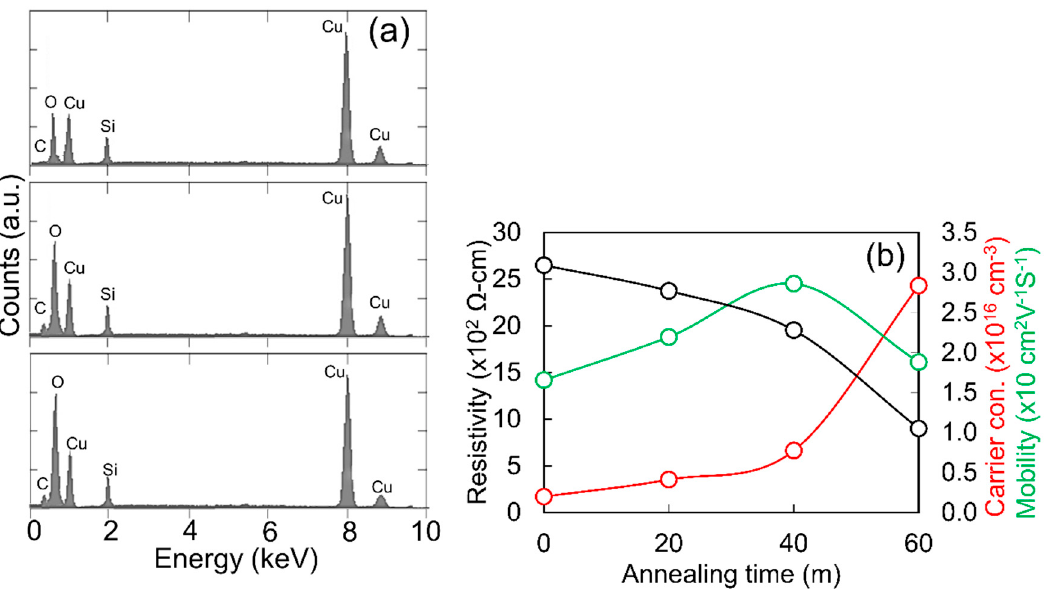
Figure 4. ( a ) The EDX spectra of Cu x O thin films (top) as-deposited, (middle) annealed for 40 min, and (bottom) annealed for 60 min and ( b ) electrical characteristics of the prepared Cu x O thin films (color of the legend determine the parameters).